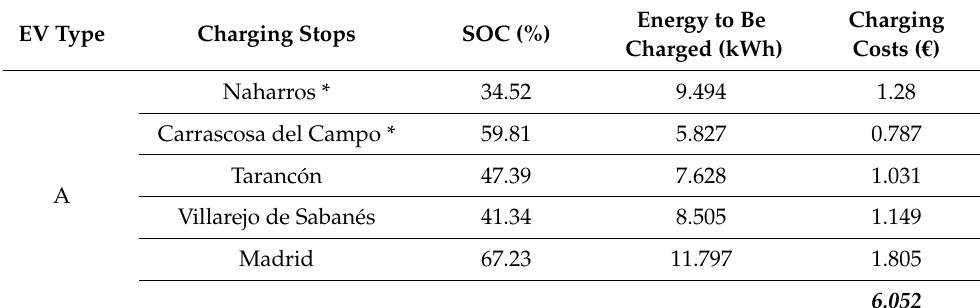
Table 7. Simulation results for EV type A on the Cuenca–Madrid route.